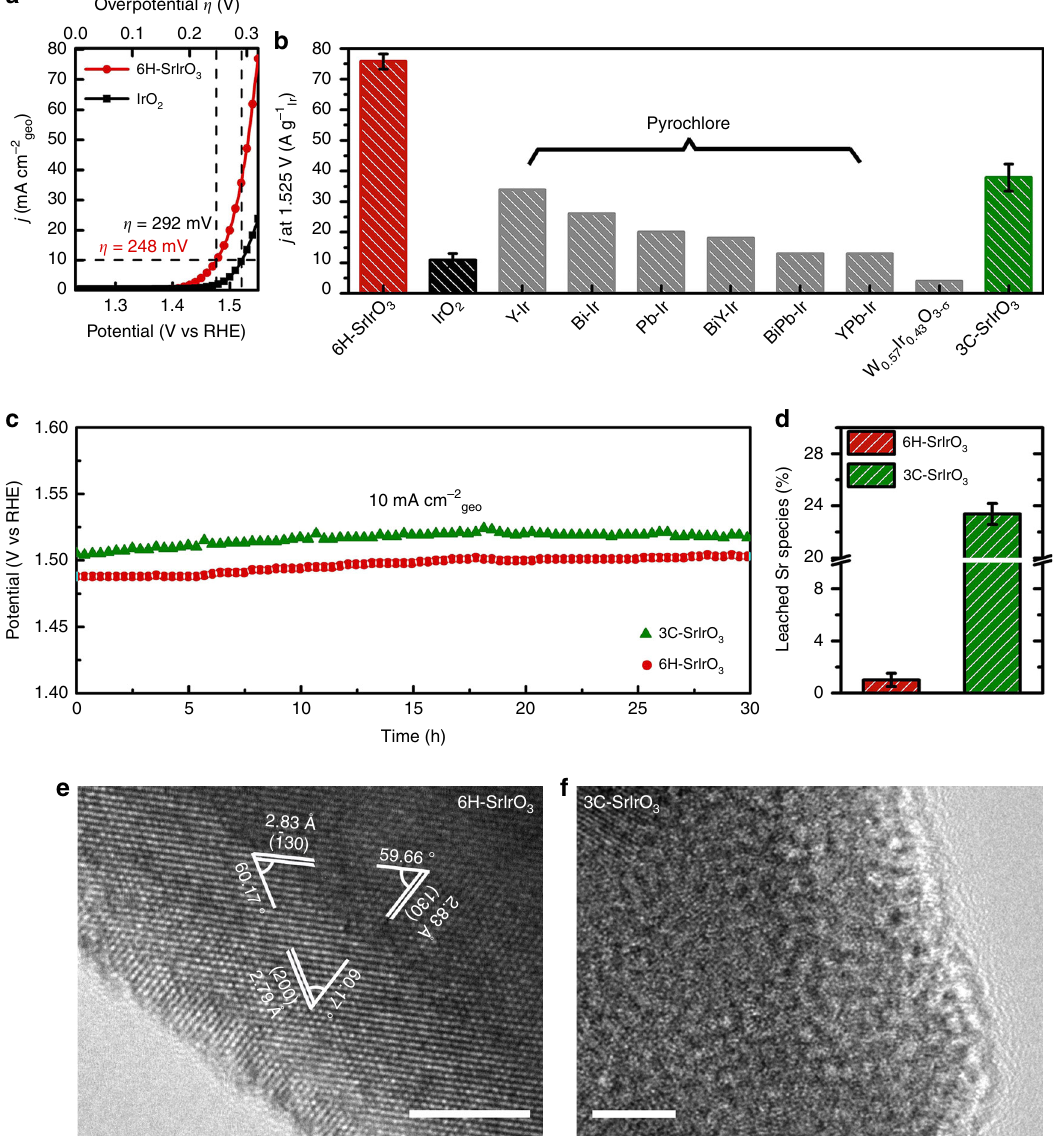
Fig. 3 Electrocatalytic properties for OER of 6H-SrIrO 3 . a Polarization curves of 6H-SrIrO 3 and IrO 2 in 0.5 M H 2 SO 4 solution with 85% iR-compensations. The current densities are normalized by the geometric area. b Comparison of mass activity, normalized by the mass of iridium at 1.525 V vs. RHE, of 6H-SrIrO 3 , IrO 2 , 3C-SrIrO 3 , and some Ir-containing catalysts reported recently. The error bar represents standard deviation based on fi ve measurements. c Chronopotentiometric curves for OER in the presence of 6H-SrIrO 3 and 3C-SrIrO 3 in 0.5 M H 2 SO 4 solution at 10 mA cm − 2 geo (without iR compensations). d Percentage of total Sr content leached (or deviated from the stoichiometry) in the solution after 30 h-long catalytic stability test in the presence of 6H-SrIrO 3 and 3C-SrIrO 3 . e , f HRTEM images for 6H-SrIrO 3 and 3C-SrIrO 3 after 30 h-long catalytic stability test. Scale bars, 5